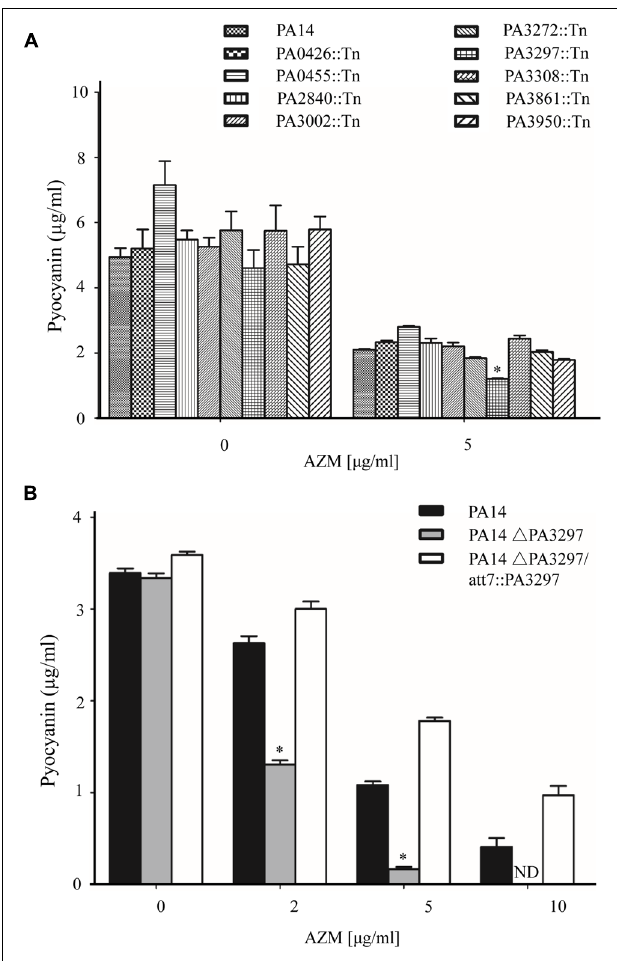
FIGURE 1 | Mutation of PA3297 intensified the AZM mediated inhibition of pyocyanin production. (A) Wild type PA14 and the mutants of DExD/H box helicases were grown to an OD 600 of 2.0 in the absence or presence of 5 µ g/ml AZM at 37 ◦ C and the pyocyanin concentrations were measured. (B) Bacteria of wild type PA14, (cid:49) PA3297 mutant and the complementation strain were grown in the absence or presence of 2, 5, or 10 µ g/ml AZM. When the OD 600 reached 2.0, the pyocyanin concentrations were measured. The values are the means of three replicates and the error bars display the standard deviations. “ND” standards for “not detected.” ∗ p < 0.05 compared to PA14 or the complemented strain by student’s t -test.